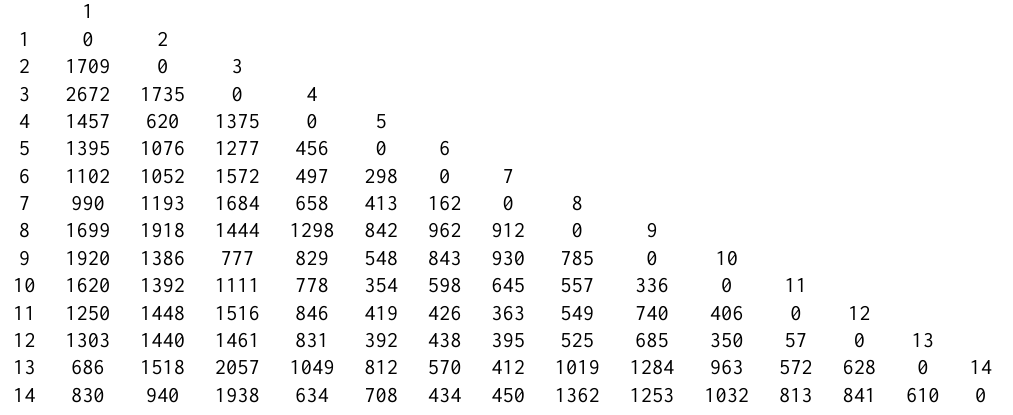
Table 1. Intra-distances (m) of the rain